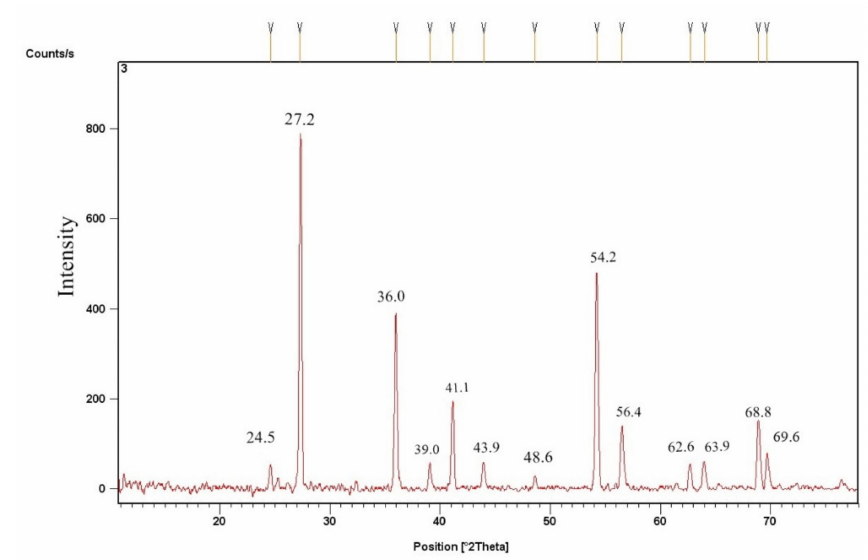
Figure 5. XRD results of TiO 2